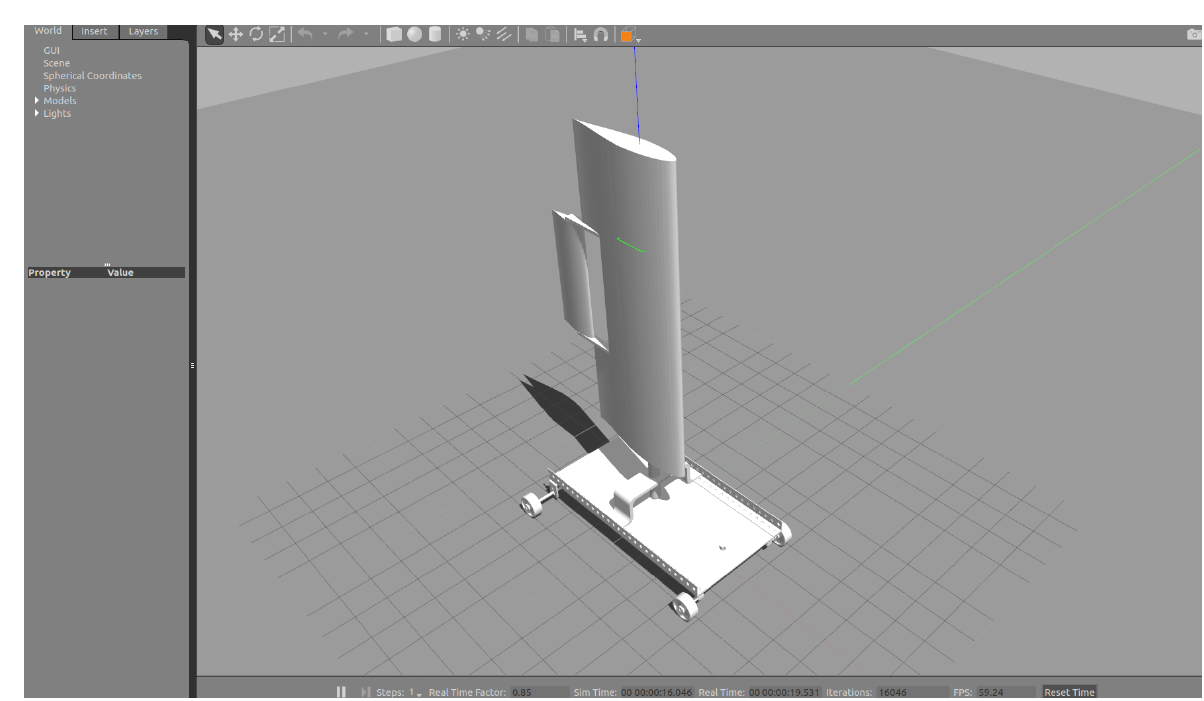
Figure 3. Land yacht 3D model in Gazebo.